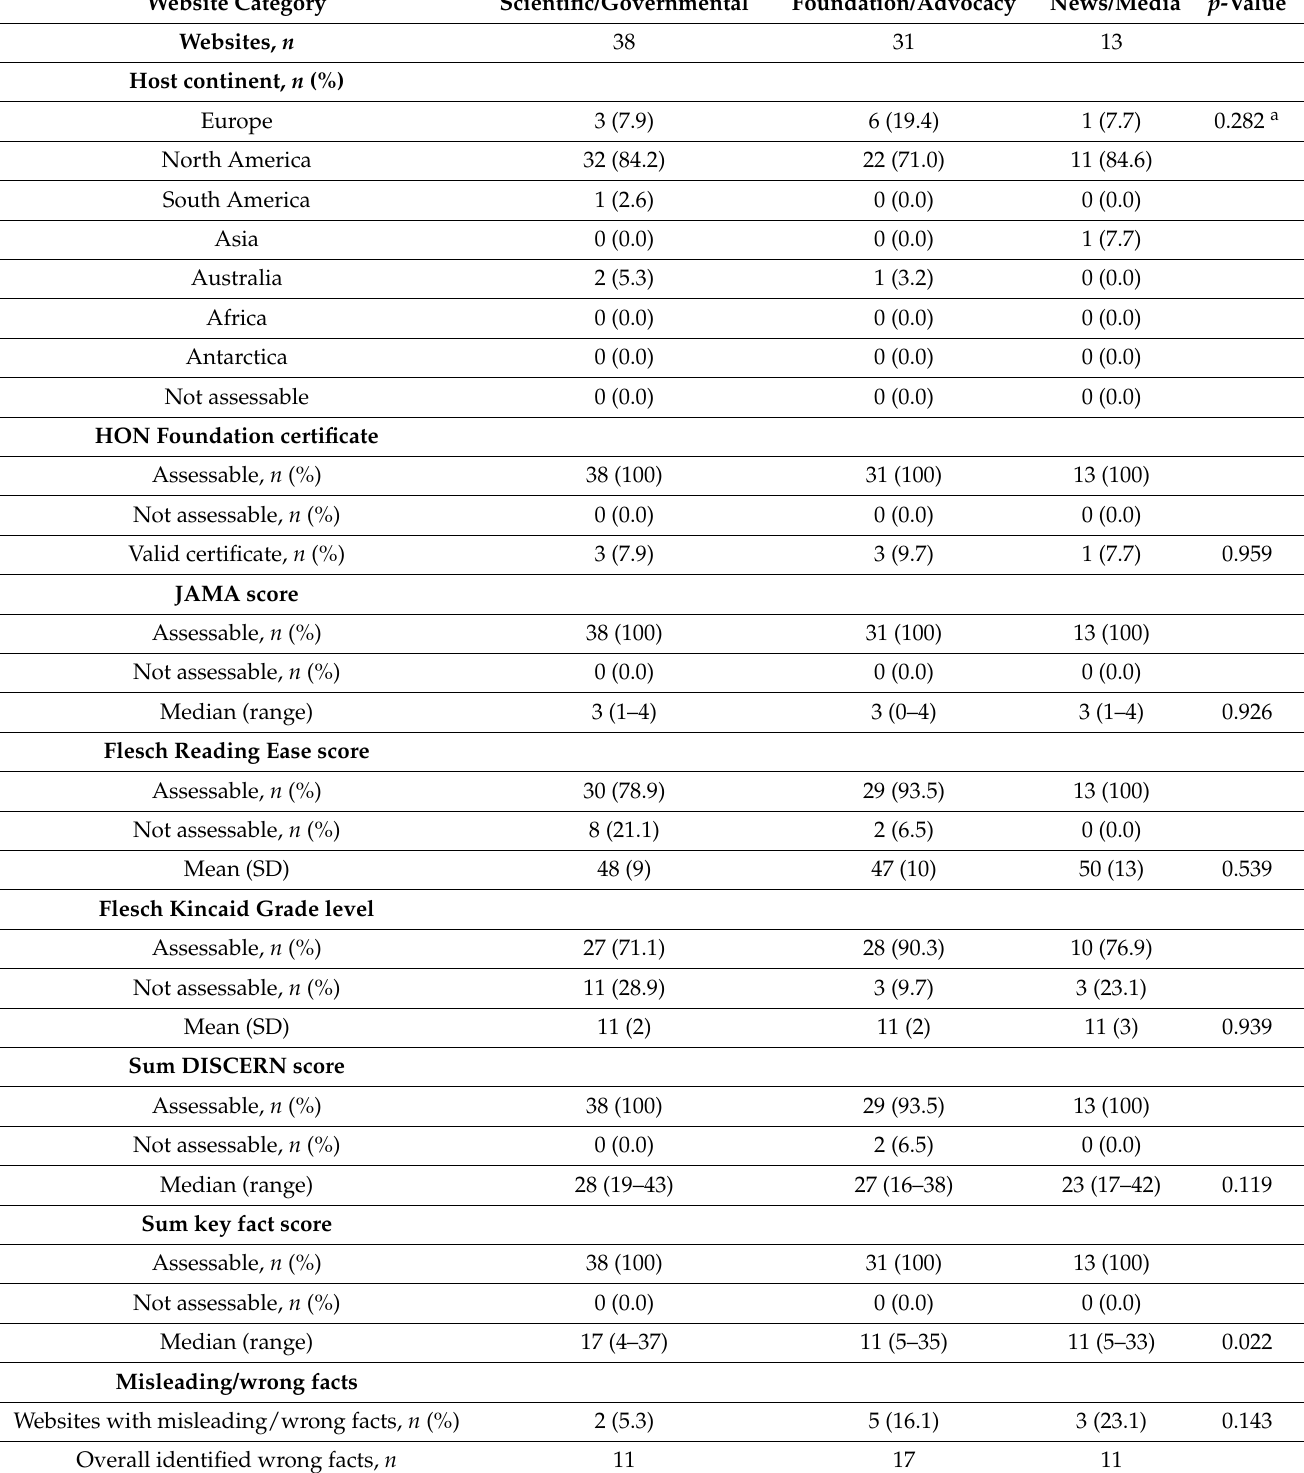
Table 4. Characterization of websites by